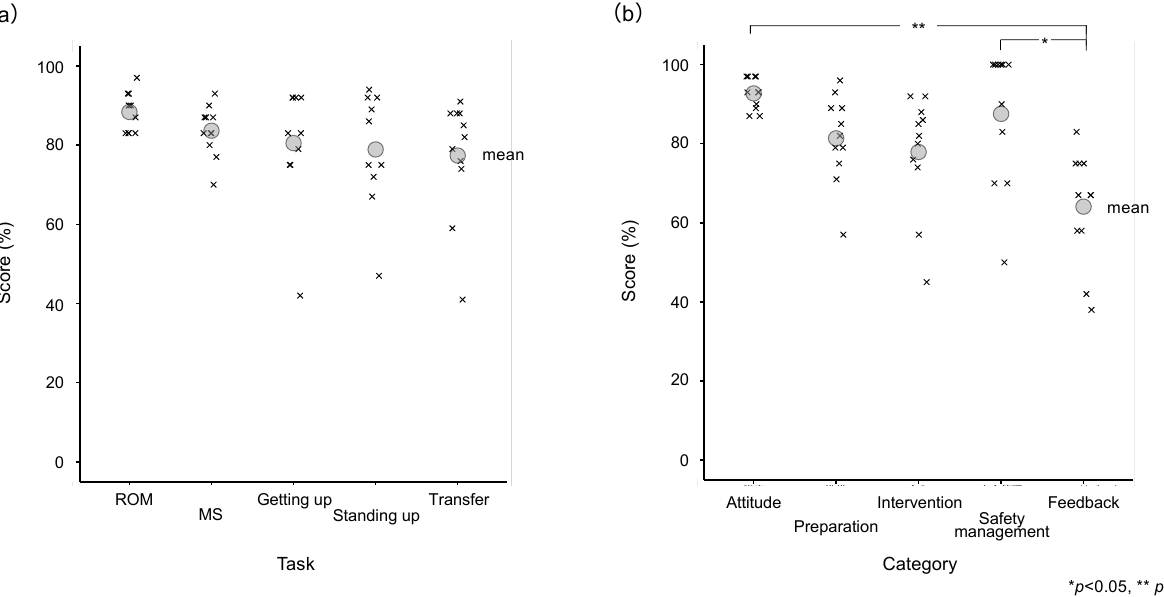
Figure 1. ( a ) Achievement rate for each task; Joint range of movement exercise showed the highest rate, while Transfer showed the lowest rate. ( b ) Achievement rate for each category; Attitude showed the highest rate, while Feedback showed the lowest